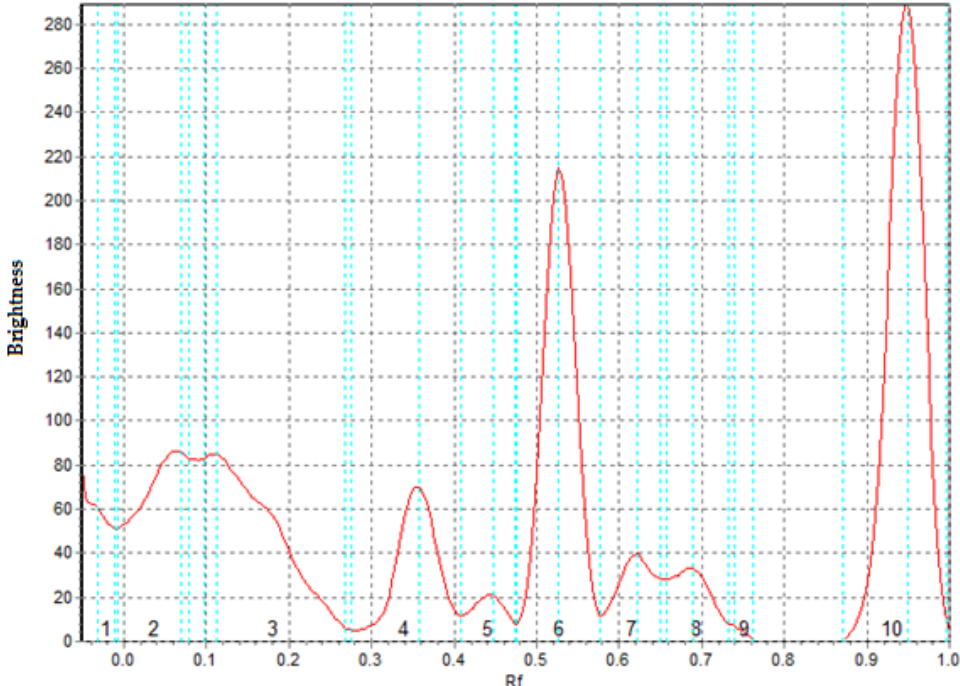
Figure 3. Densitogram of Symphytum officinale root extract. 9-Angeloylretronecin (IUPAC ((7R,8R)-7-hydroxy-5,6,7,8-tetrahydro-3H-pyrrolizin-1-yl)methyl (Z)-2-methylbut-2-enoate) and 7-Angeloylheliotridine (IUPAC ((1S,8R)-7-(hydroxymethyl)-2,3,5,8-tetrahydro-1H-pyrrolizin-1-yl) (Z)-2-methylbut-2-enoate) were found in comfrey extract samples. Their structural formulae as well as mass spectra are shown in Figures 4 and 5. The pyrrolizidine alkaloids (PA) found in the comfrey extract samples contained fragmentary ions m/z 125 ± 1, and m / z 137 ± 1, which are characteristic of the retronecin fragment [17].